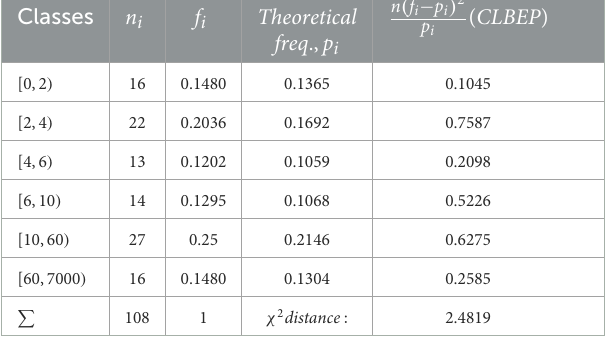
TABLE 6 Estimated values of fitted models and − LL , AIC , AICc , and BIC data set